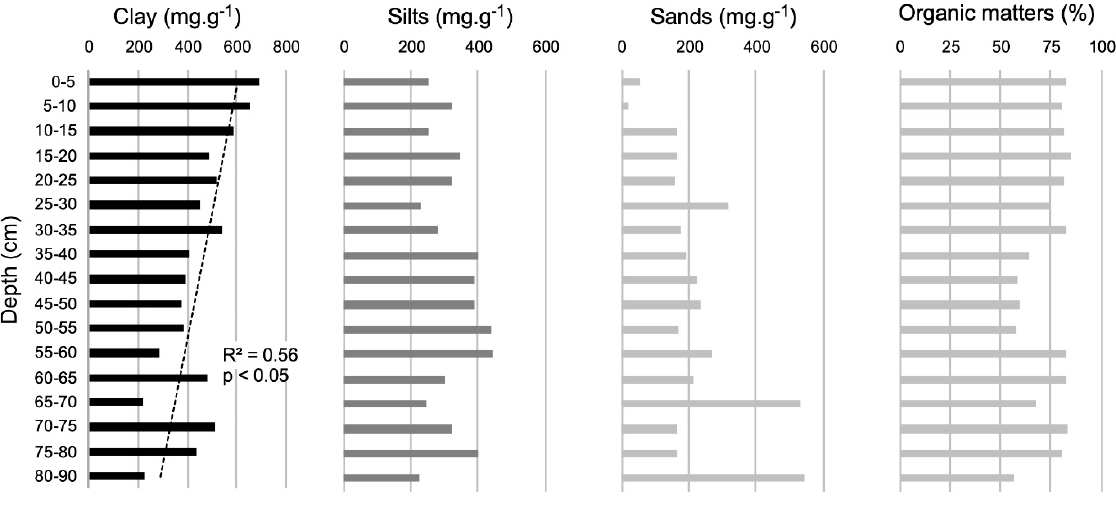
Figure 3. Concentration of clay, silts, and sands on the mineral matters fraction, and organic matter percentage inferred from loss-on-ignition at 550 °C. The dashed line represents a linear regression; the associated correlation and p -values are shown beside it.